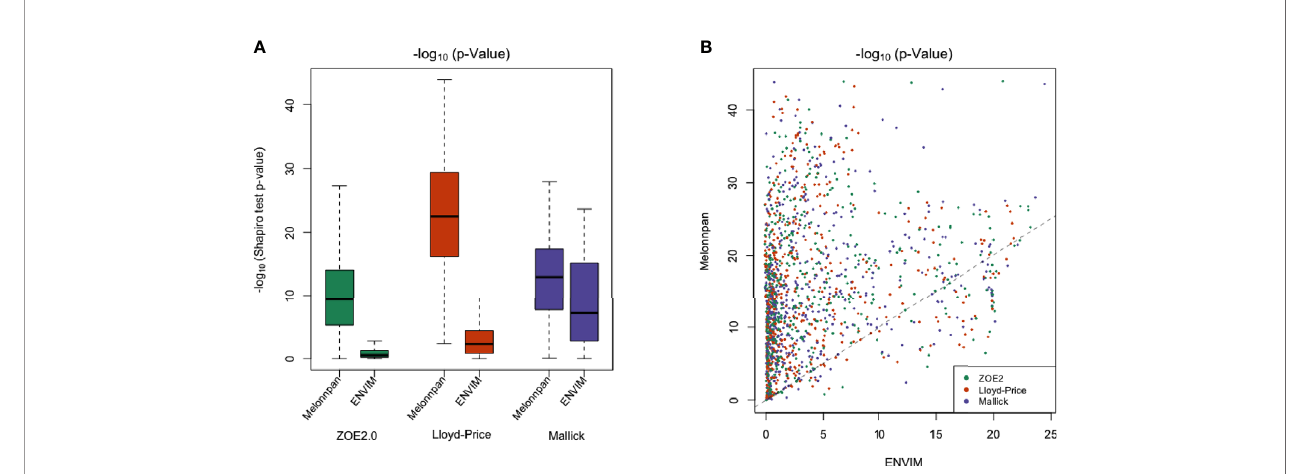
FIGURE 3 | (A) Boxplot of − log 10 of Shapiro – Wilk test p -values to test the normality of transformed relative metabolite abundances in all three data applied with Box – Cox transformation (ENVIM used) and arcsine square root transformation (MelonnPan used). (B) Scatter plot for comparing − log 10 of p -values from the Shapiro – Wilk test (normality) between Box – Cox transformation ( x -axis) and arcsine sqrt ( y -axis) transformation. Almost all of the points are above the y = x line, which indicates that the − log 10 of p -value after Box – Cox transformation is smaller than after arcsine sqrt transformation and normality after Box – Cox transformation is better. Each point is one